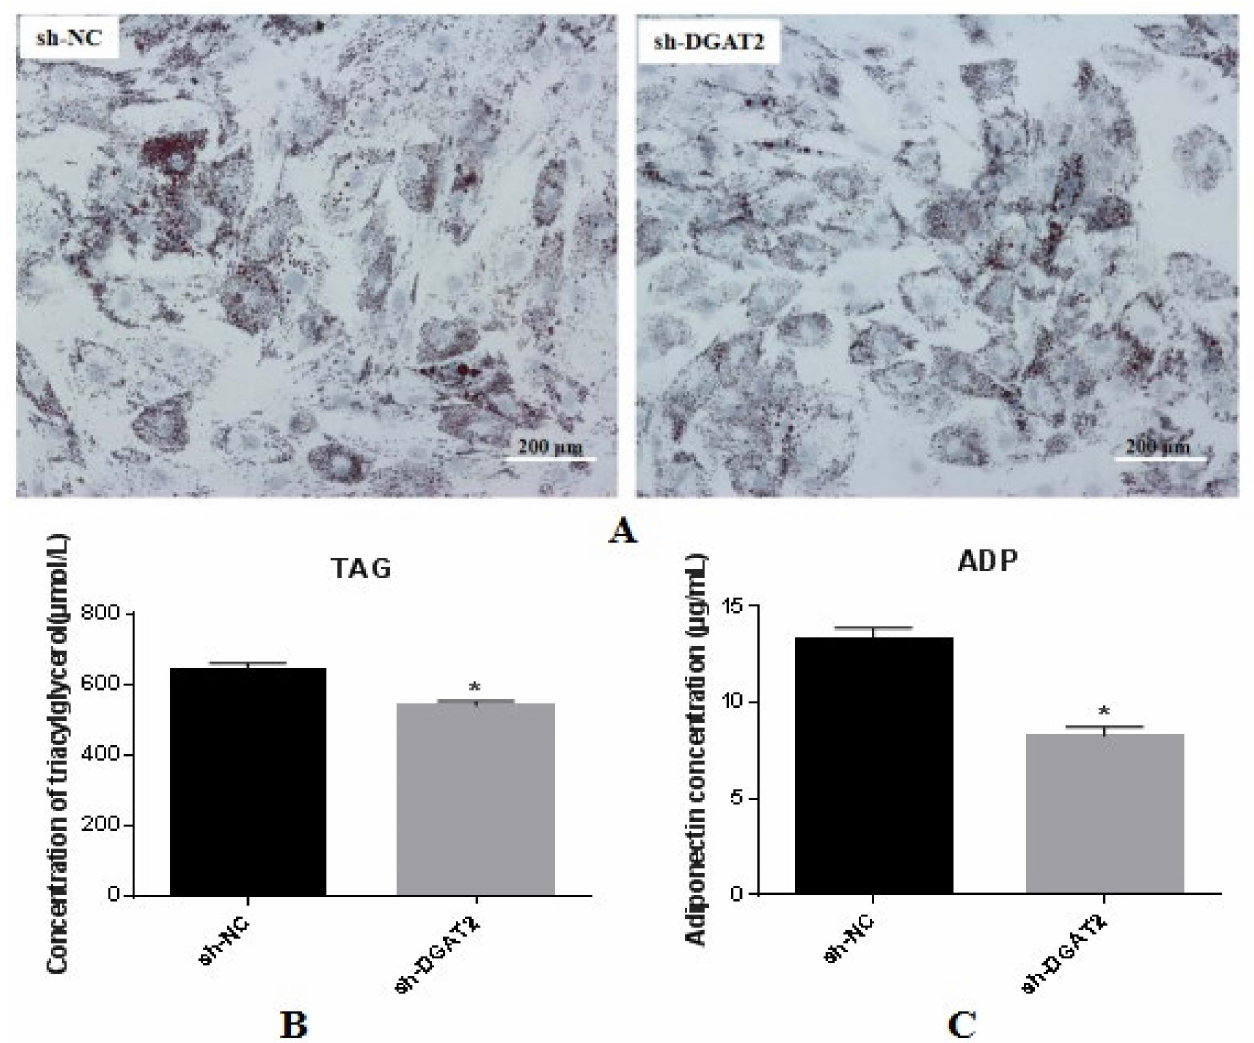
Figure 4. Interference of DGAT2 inhibits BSCs lipid droplet accumulation and reduces cellular TAG concentration and adiponectin content in the medium. ( A ) Oil red O staining (scale bar: 200 µ m). ( B ) The effect of interfering DGAT2 on TAG content in BSCs. ( C ) The effect of interfering DGAT2 on ADP content in the medium. Values are presented as means ± SEM from three individual cultures. * p <